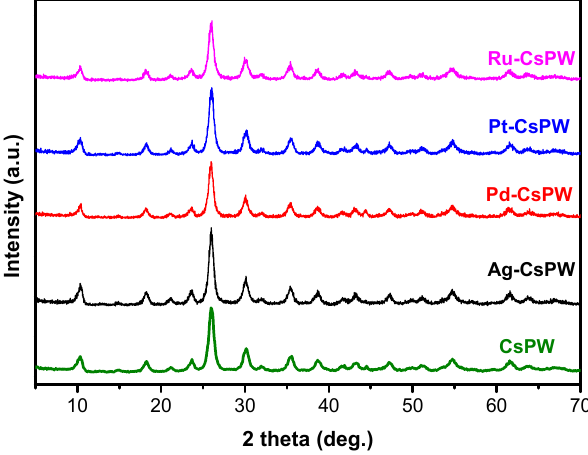
Figure 1. X-ray diffraction (XRD) patterns for Ru-CsPW, Pt-CsPW, Pd-CsPW, and Ag-CsPW.